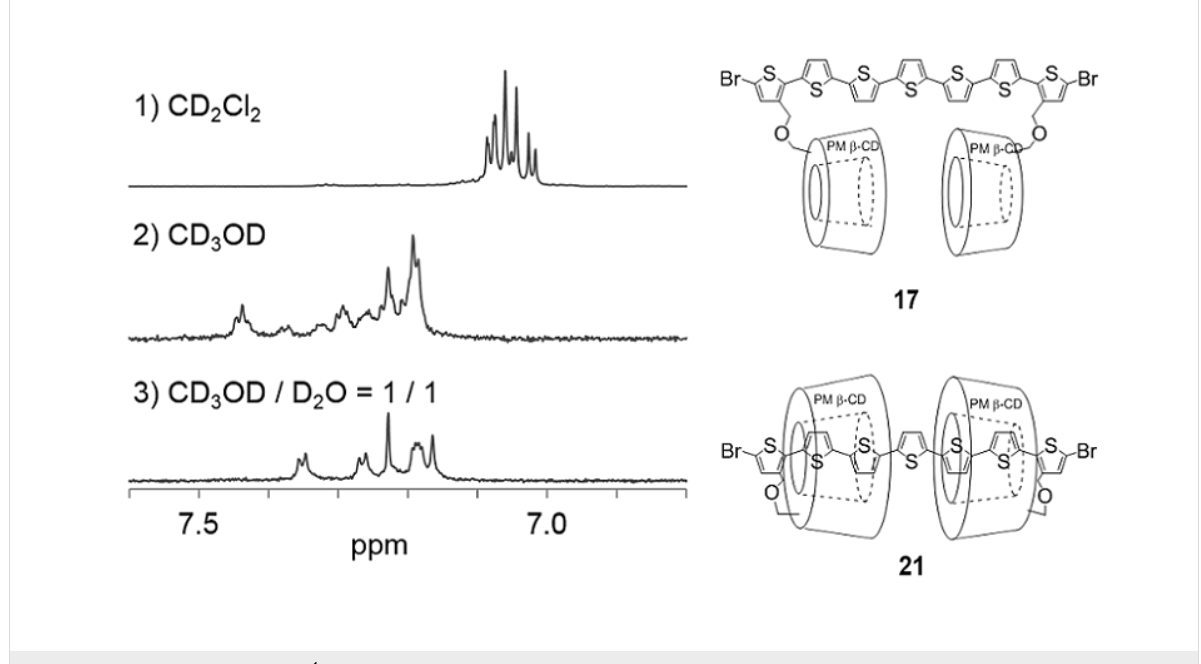
were also confirmed by 1 H NMR spectroscopy in different solvents (Figure 4 and Figure 5, Supporting Information File 1, Figure S2). These linked [3]rotaxanes can be key monomers for synthesizing organic soluble IMWs bearing polythiophene or poly( para -phenylene) as backbone